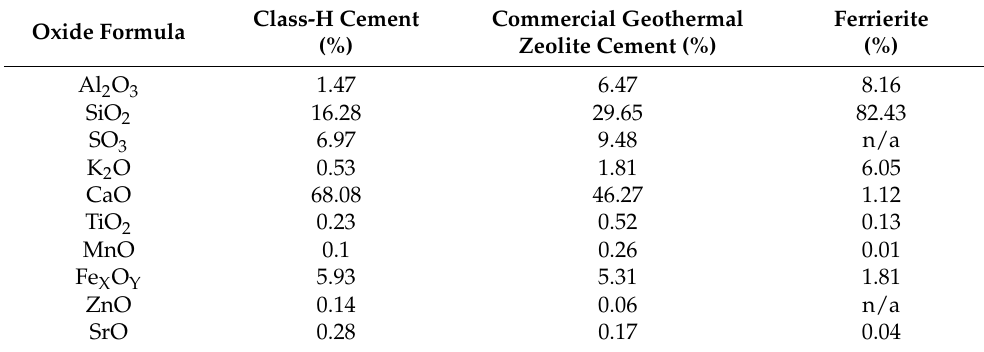
Table 1. Oxides present in neat Class-H cement, geothermal zeolite cement and ferrierite by weight